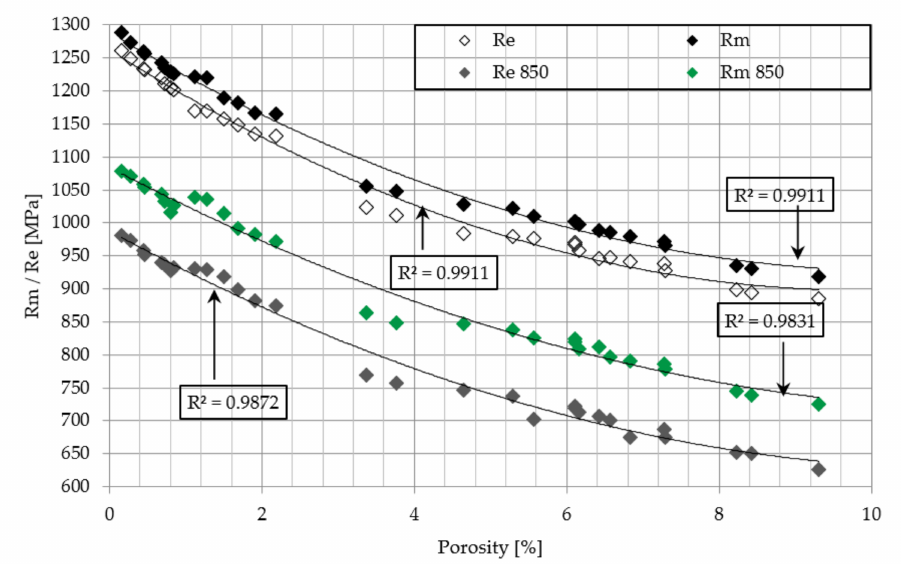
Figure 11. Influence of porosity on Ultimate Tensile Strength and Yield Strength of as-build and heat treated at 850 ◦ C samples.